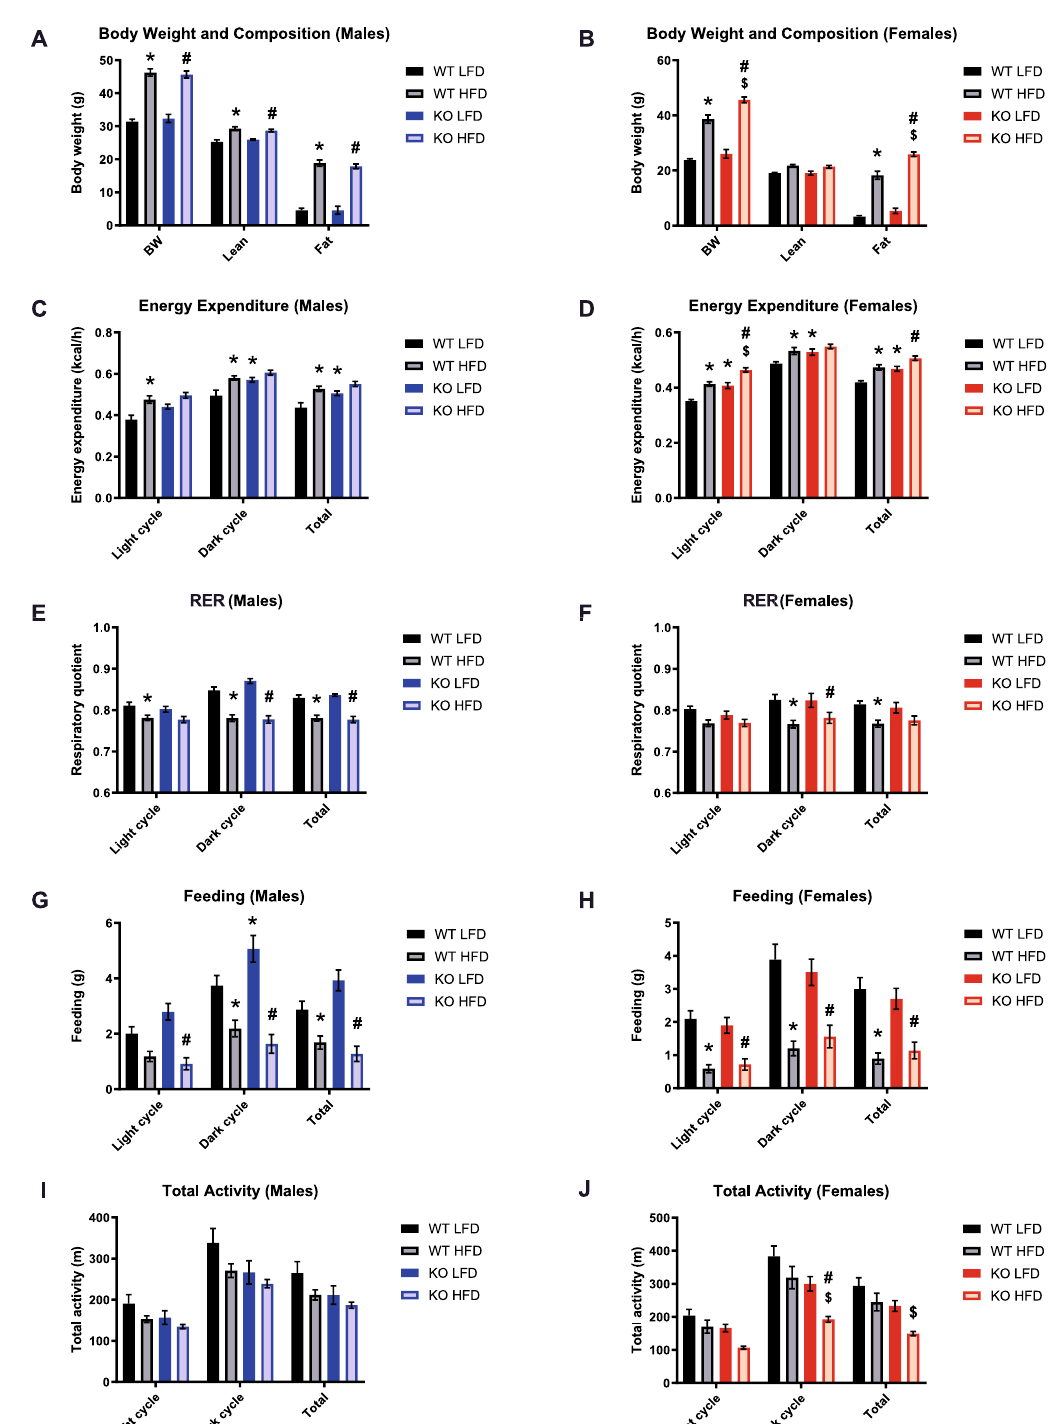
Figure 1. GPR19 deficiency modifies whole body metabolism. Male and female wildtype or GPR19 KO mice were fed a low fat diet (LFD) and subject to metabolic cage analysis. The same mice were then placed on a high fat diet (HFD) for 10 weeks, after which a repeat metabolic cage was performed. ( A, B ) Body weight and composition, ( C, D ) energy expenditure, ( E, F ) respiratory quotient (RQ), ( G, H ) feeding, and ( I, J ) total activity were measured in males and females, respectively. * P < 0.05 versus WT LFD, # P < 0.05 versus KO LFD, $ P < 0.05 versus WT HFD, N =